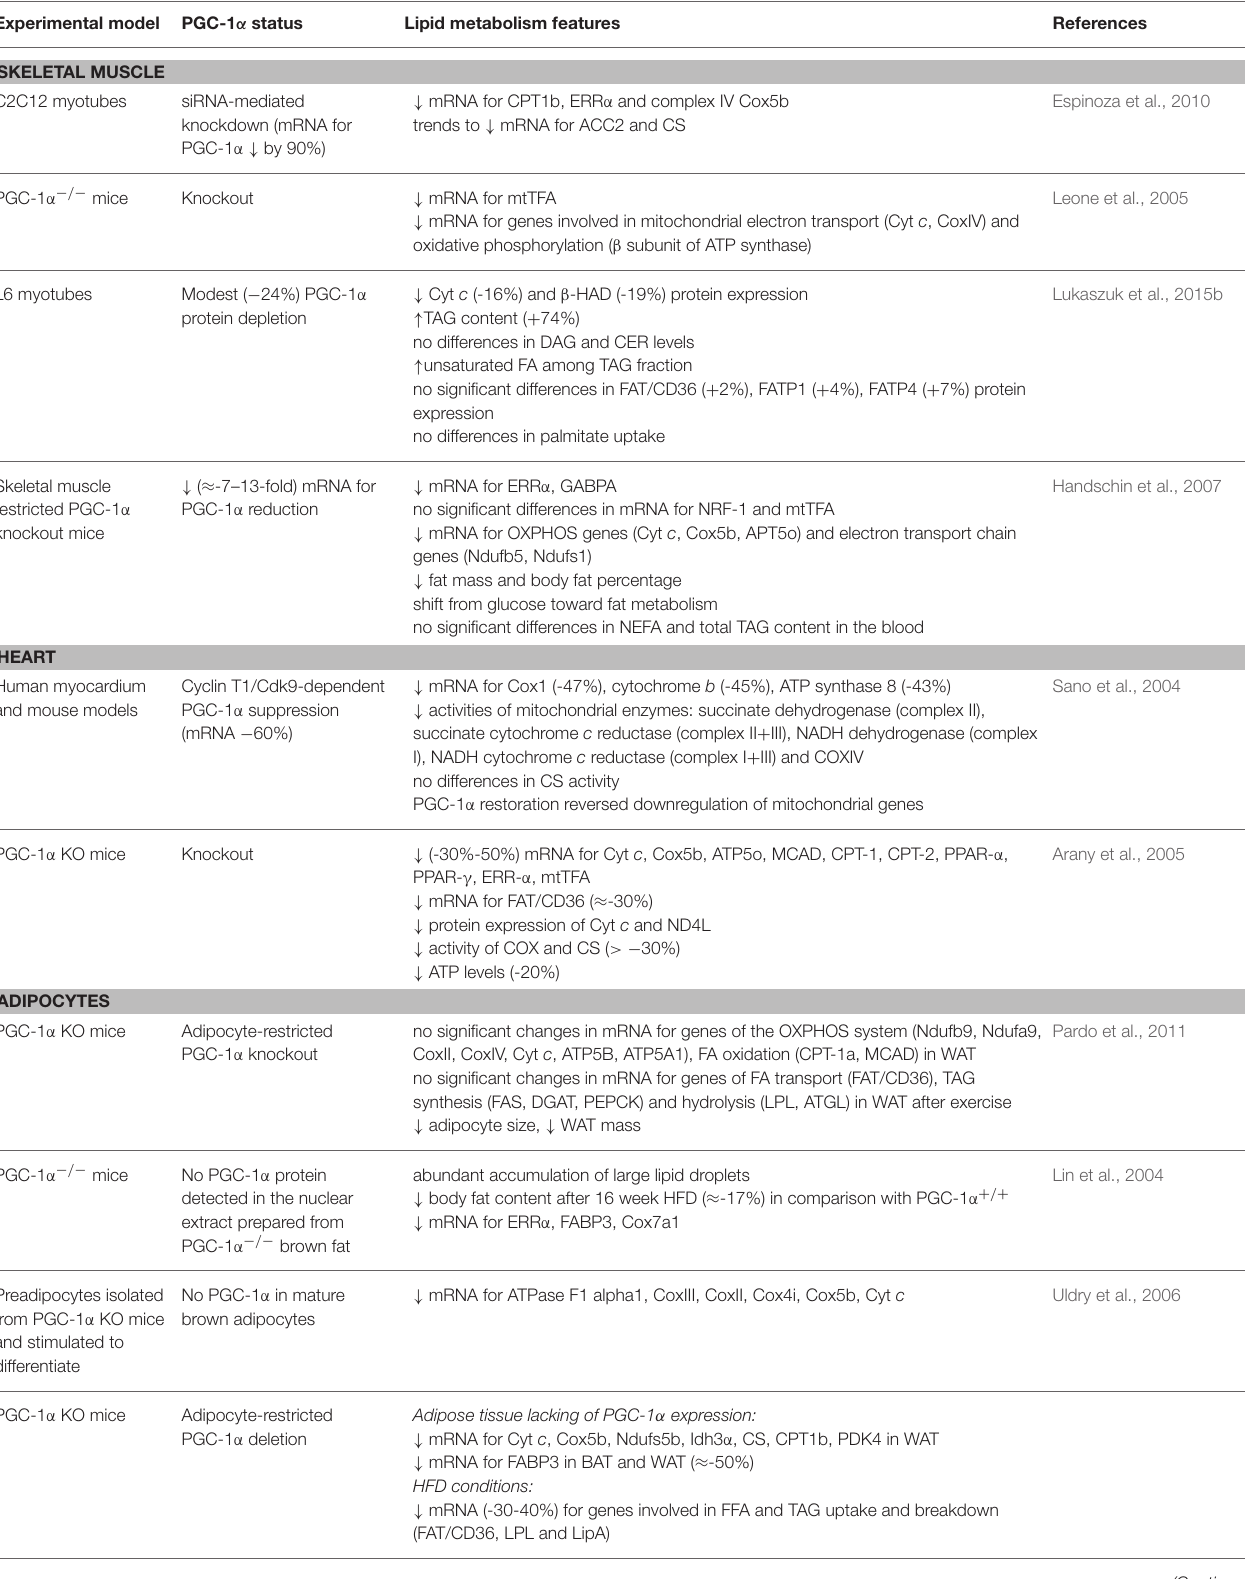
TABLE 2 | The effects of PGC-1 α downregulation on the lipids